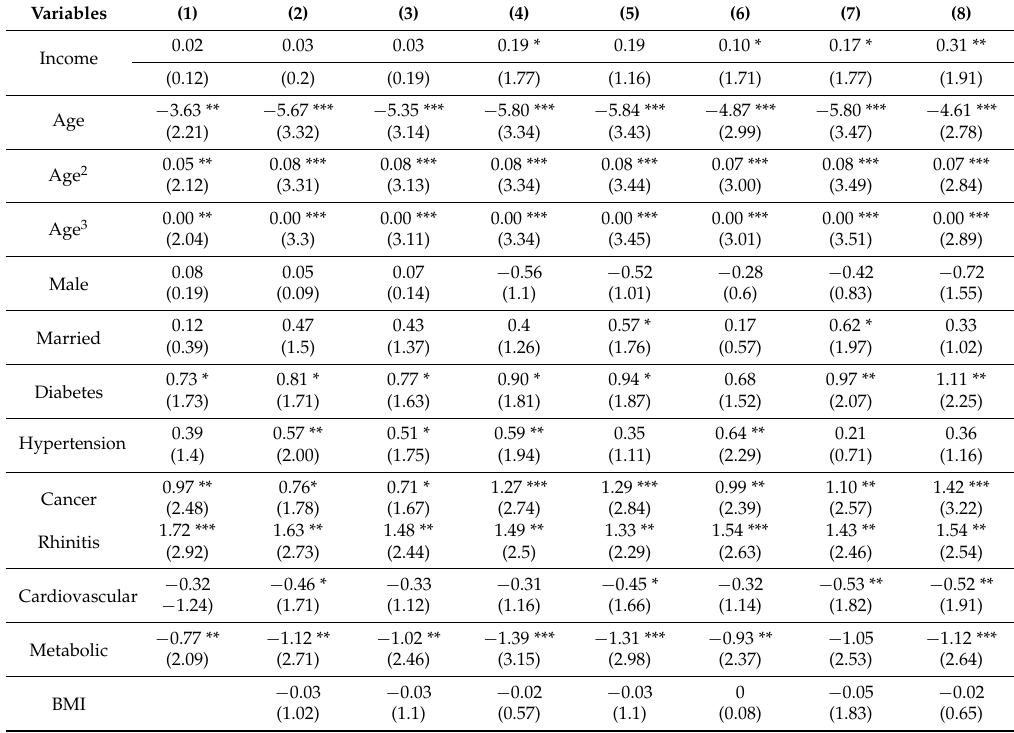
Table 5. Regression results for WTP for a COPD